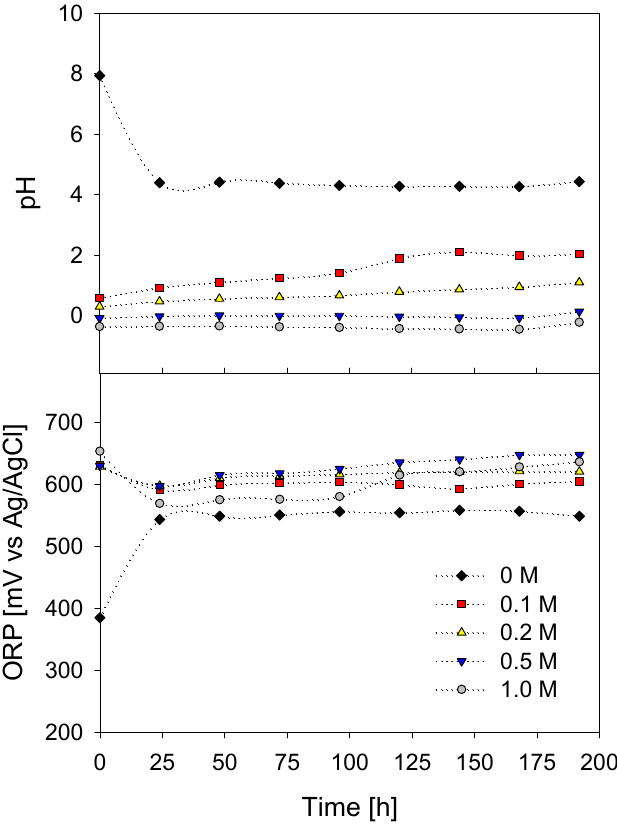
Figure 15. pH–ORP vs Leaching time. [H 2 SO 4 ] = ( )= 0 M; ( ■ ) = 0.1 M; ( ▲ ) = 0.2 M; ( ▼ ) = 0.5 M; ( ) = 1.0 M. [Conditions: KI = 100 ppm, T = 45 °C, 50 g of sample in 1000 mL of solution with sea- water, 450 rpm].